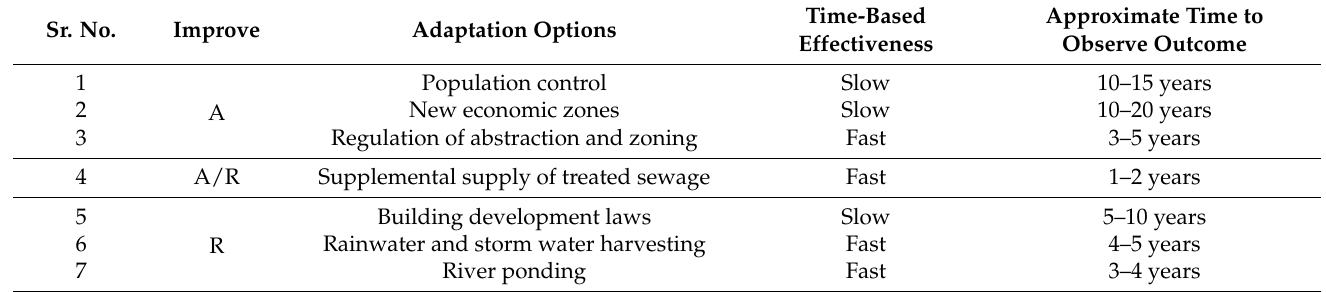
Table 6. Proposed adaptation options to counter the negative impacts on groundwater resources in